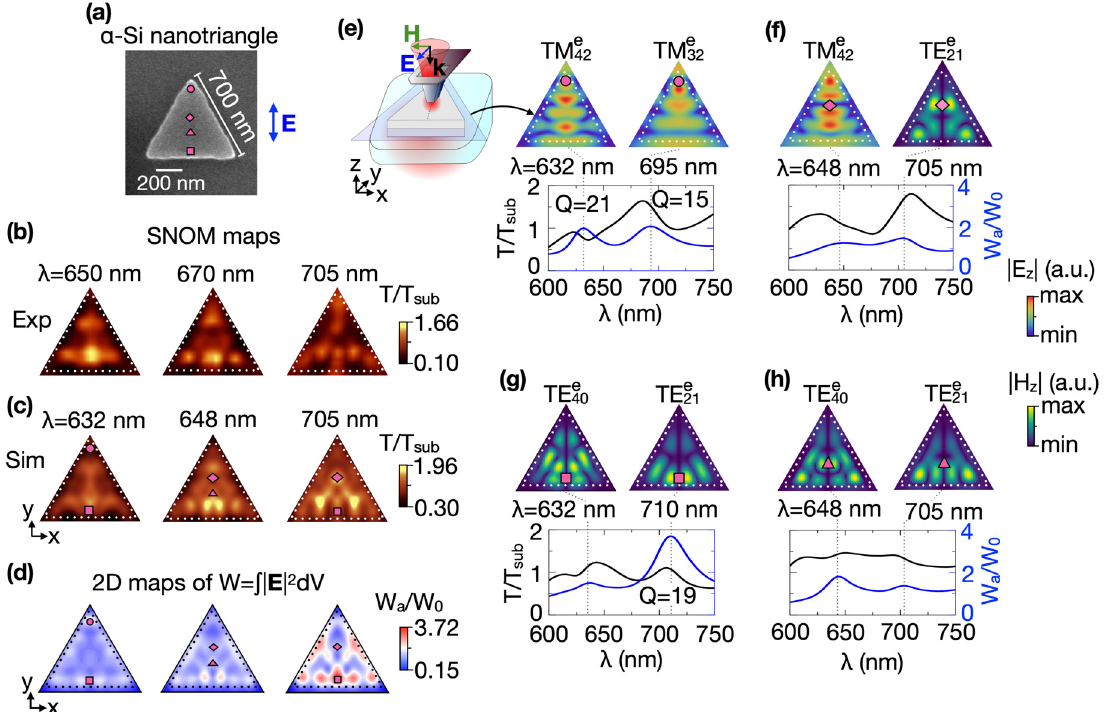
Figure 3: (a) SEM image of the equilateral 𝛼 -Si nanotriangle. The side length of triangle is 700 nm, and the thickness is 100 nm. The blue arrow indicates the y − polarization of light focused in the SNOM probe. Experimental (b) and simulated (c) SNOM maps of the 𝛼 -Si /W at the same wavelengths of equilaterale nanotriangle for y − polarized excitation. (d) Simulated 2D maps of electric field localization W 0 a the SNOM maps in (c). The circle ( x = 0 nm, y = 580 nm), square ( x = 0 nm, y = 120 nm), diamond ( x = 0 nm, y = 360 nm), and triangle ( x = 0 nm, y = 260 nm) symbols on (a), (c), and (d) depict the SNOM probe positions corresponding to maxima of electric field localization. (black curves) and electric field localization W /W (blue curves) spectra recorded at the (e–h) The simulated SNOM transmittance T / T sub 0 a /W (d) maps. The top rows in (e–h) show the fixed positions of the SNOM probe marked as purple symbols on the SNOM (c) and W 0 a | and | H | distributions for TM e | and | H | field was taken at central xy − cross-sections of and TE e modes, respectively. The | E simulated | E z z z z mn mn the nanotriangle as shown in the sketch in panel (e). Dotted white and black lines indicate the boundary of the nanotriangle.